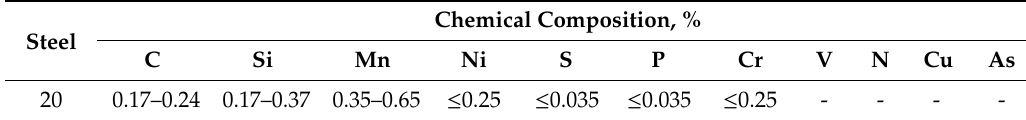
Table 1. Chemical composition of steel